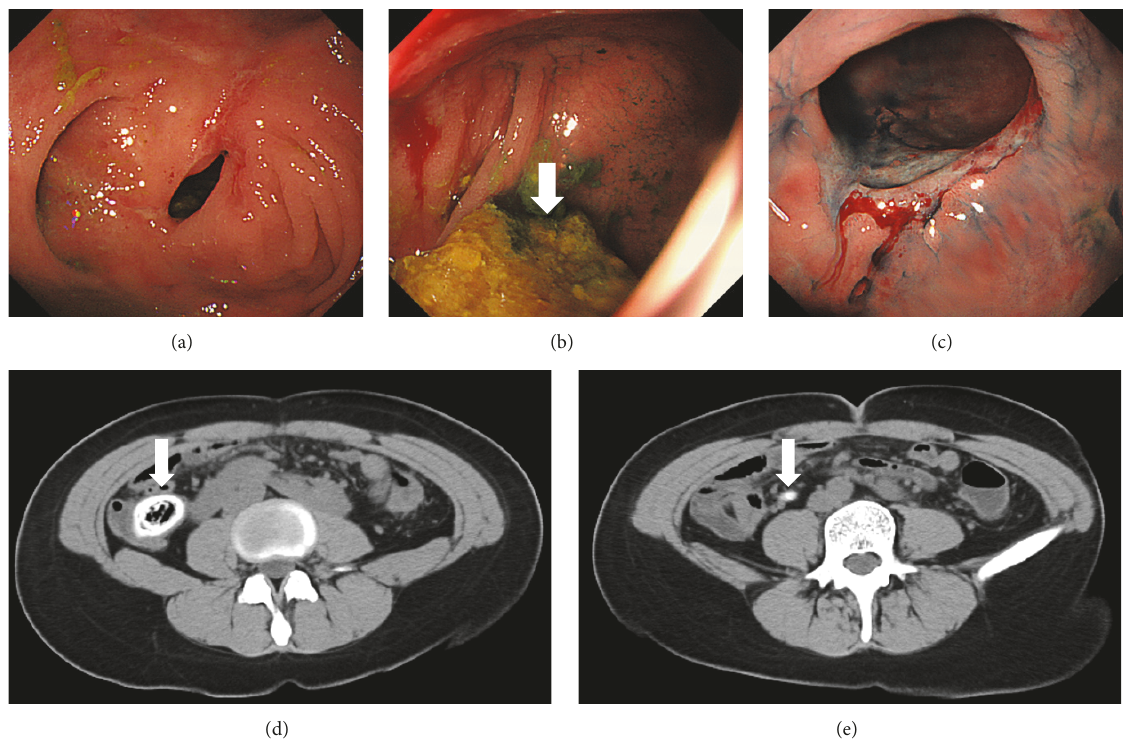
Figure 1: Endoscopic and radiologic images. Colonoscopy performed 15 months previously shows ulceration and stenosis (a) and a mass trapped in the semi-closed lumen in the cecum ((b), arrow). Another ulceration is observed in the anastomotic site (c). CT shows a calcified mass in the cecum ((d), arrow) and fecalomas within the appendix ((e),